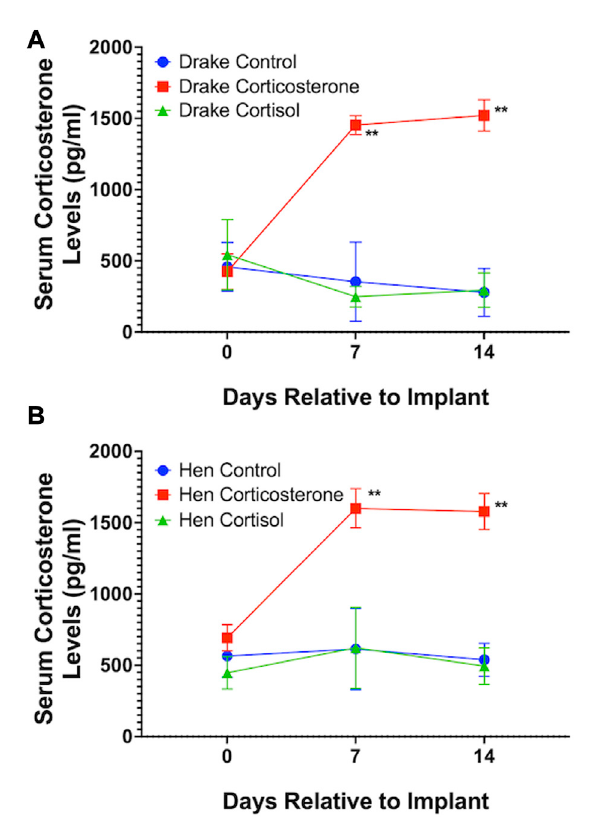
FIGURE 2 Serum corticosterone levels in Drakes (A) and Hens (B) . Only ducks treated with corticosterone showed a signi fi cant increase in serum corticosterone levels compared to controls at 7 and 15 days after onset of treatment. ** = p < 0.01.